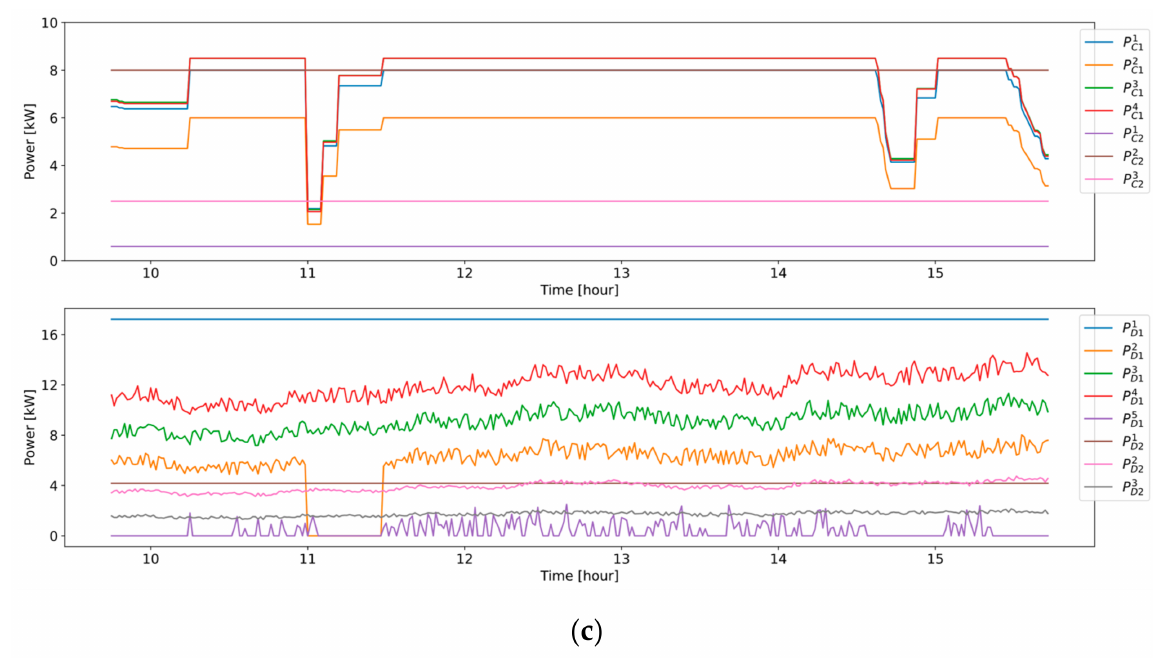
Figure 18. Test results of Case-d: A large load is connected at 11 AM for 30 min. ( a ) Variation of the total load demand and PV generation. ( b ) Variation of the DG power output, curtailed PV generation, BSS SOC, BSS energy, and obtained dispatch rules during the test. ( c ) Illustration of power of individual DCLs and CCLs through the test.